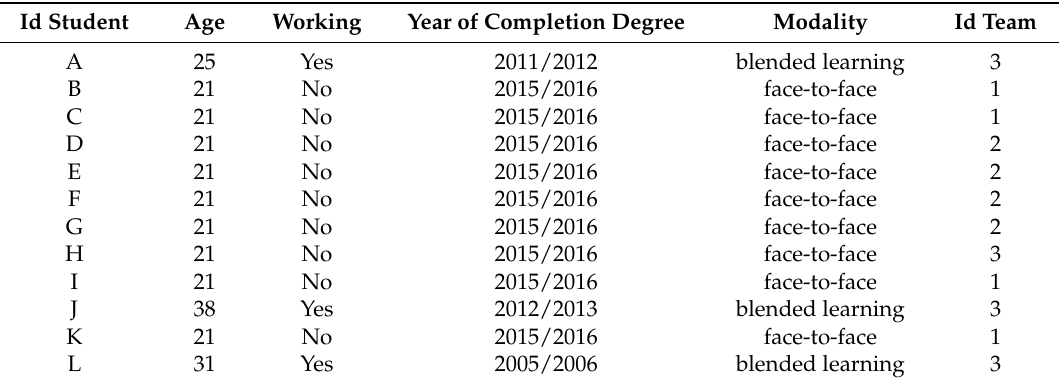
Table 2. Characteristics of the sample.